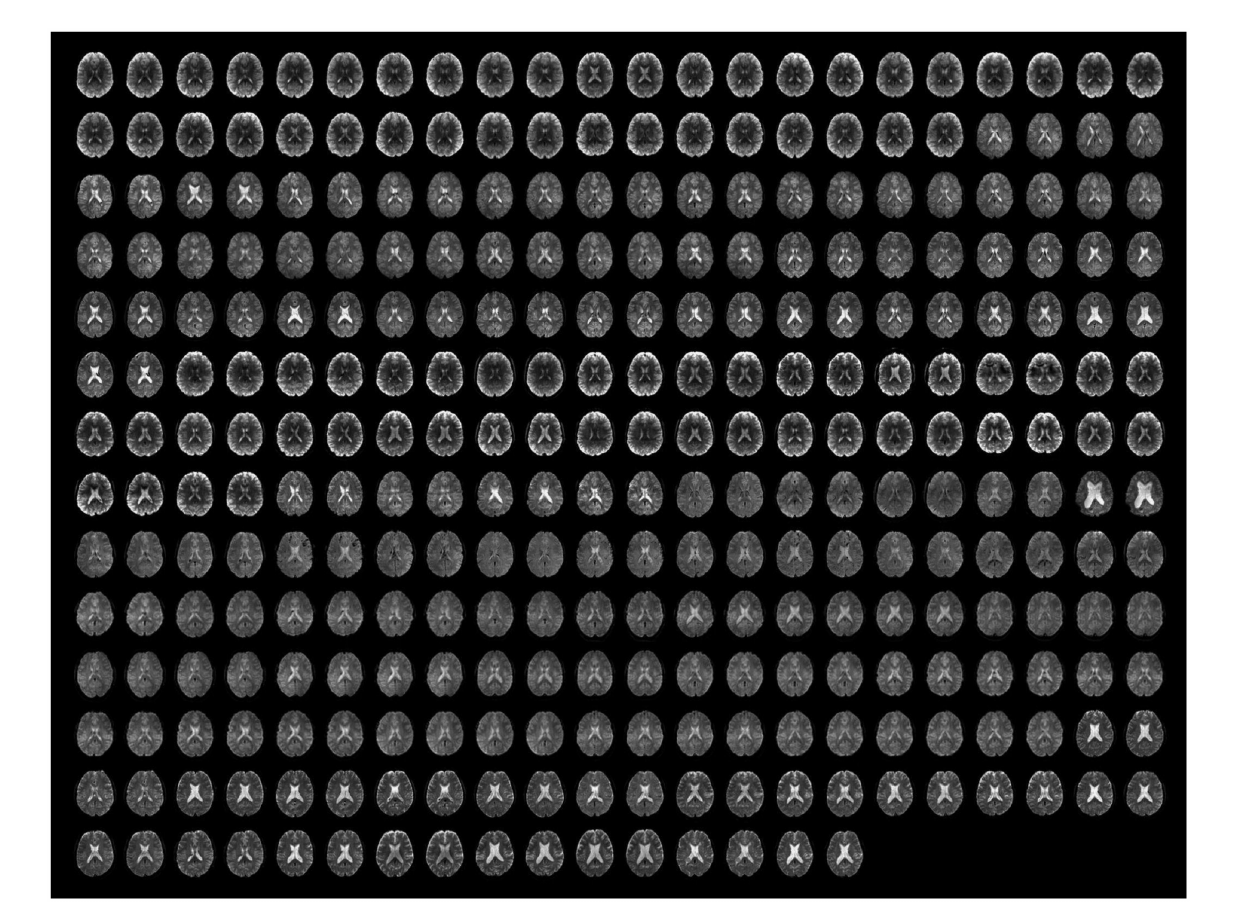
FIGURE 8 Preprocessed unsmoothed functional data. The same axial slice (MNI z = 18) for the first and the last functional scan are rendered for all runs ( n = 151). For visualization purposes only, the BOLD signal intensity of each scan was scaled by its average